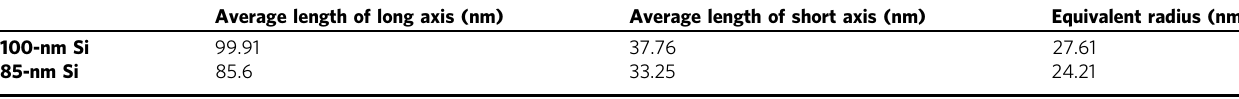
Average dimensions of silicon particles obtained from SEM micrographs.